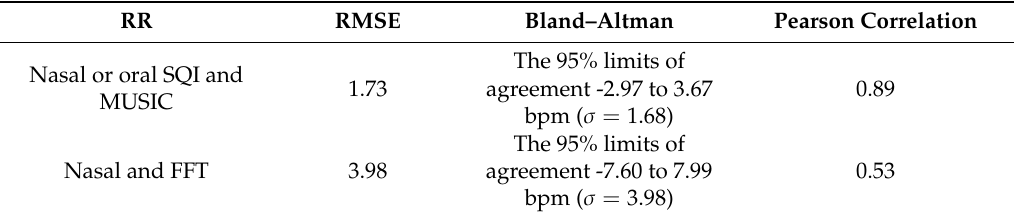
Table 2. Comparison of proposed Nasal / oral SQI method with conventional nasal alone method on RR measurement.